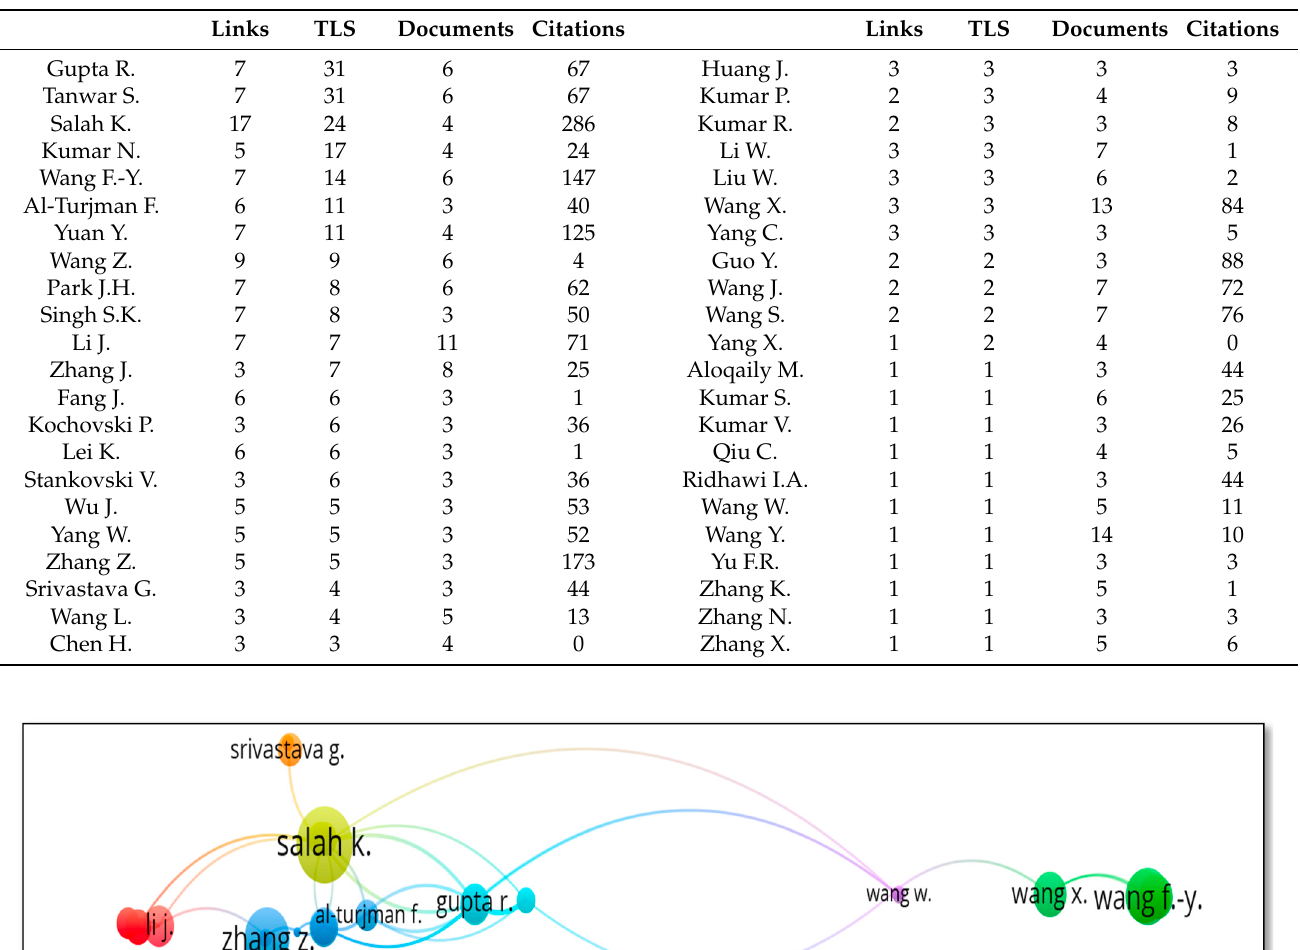
Table 12. Links, TLS, Documents and Citations for Citation Analysis (Authors). Links TLS Documents Citations